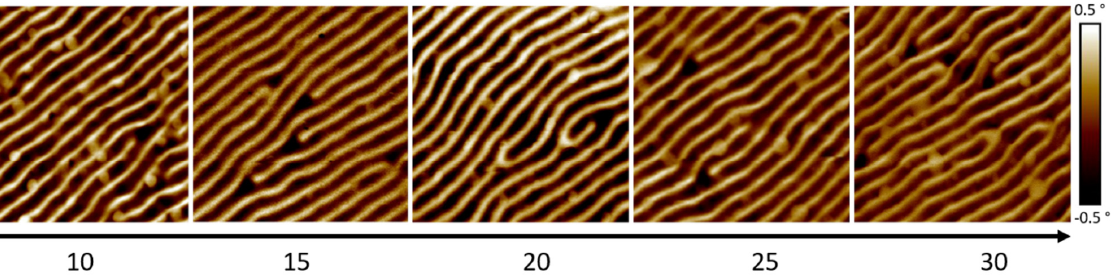
Figure 3. 2 × 2 µ m 2 wide MFM phase maps of the CoPt multilayer sample, imaged with α -pillars fabricated at different E 0 , while patterning design and I 0 were kept identical and similar, respectively, Figure 3. 2 (cid:3400) 2 µm² wide MFM phase maps of the CoPt multilayer sample, imaged with α‐ pillars as specified in the main fabricated at different 𝐸 (cid:2868) , while patterning design and 𝐼 (cid:2868) were kept identical and similar, respec ‐ tively, as specified in the main text.